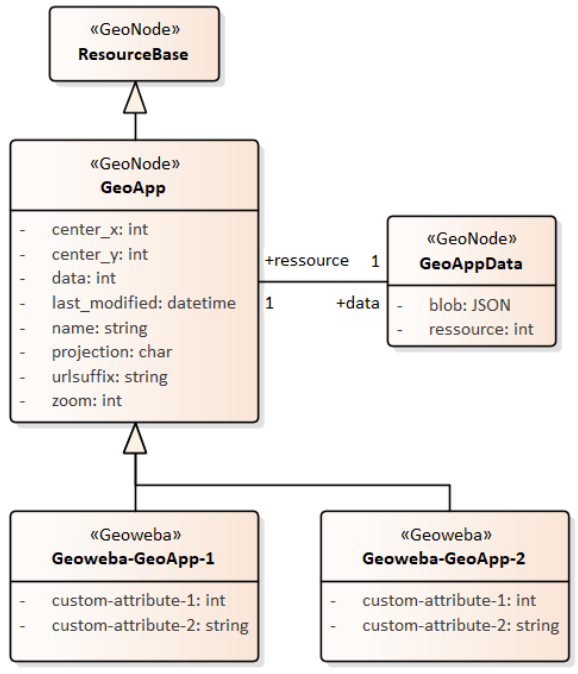
Figure 3 . Class diagram for GeoApps.